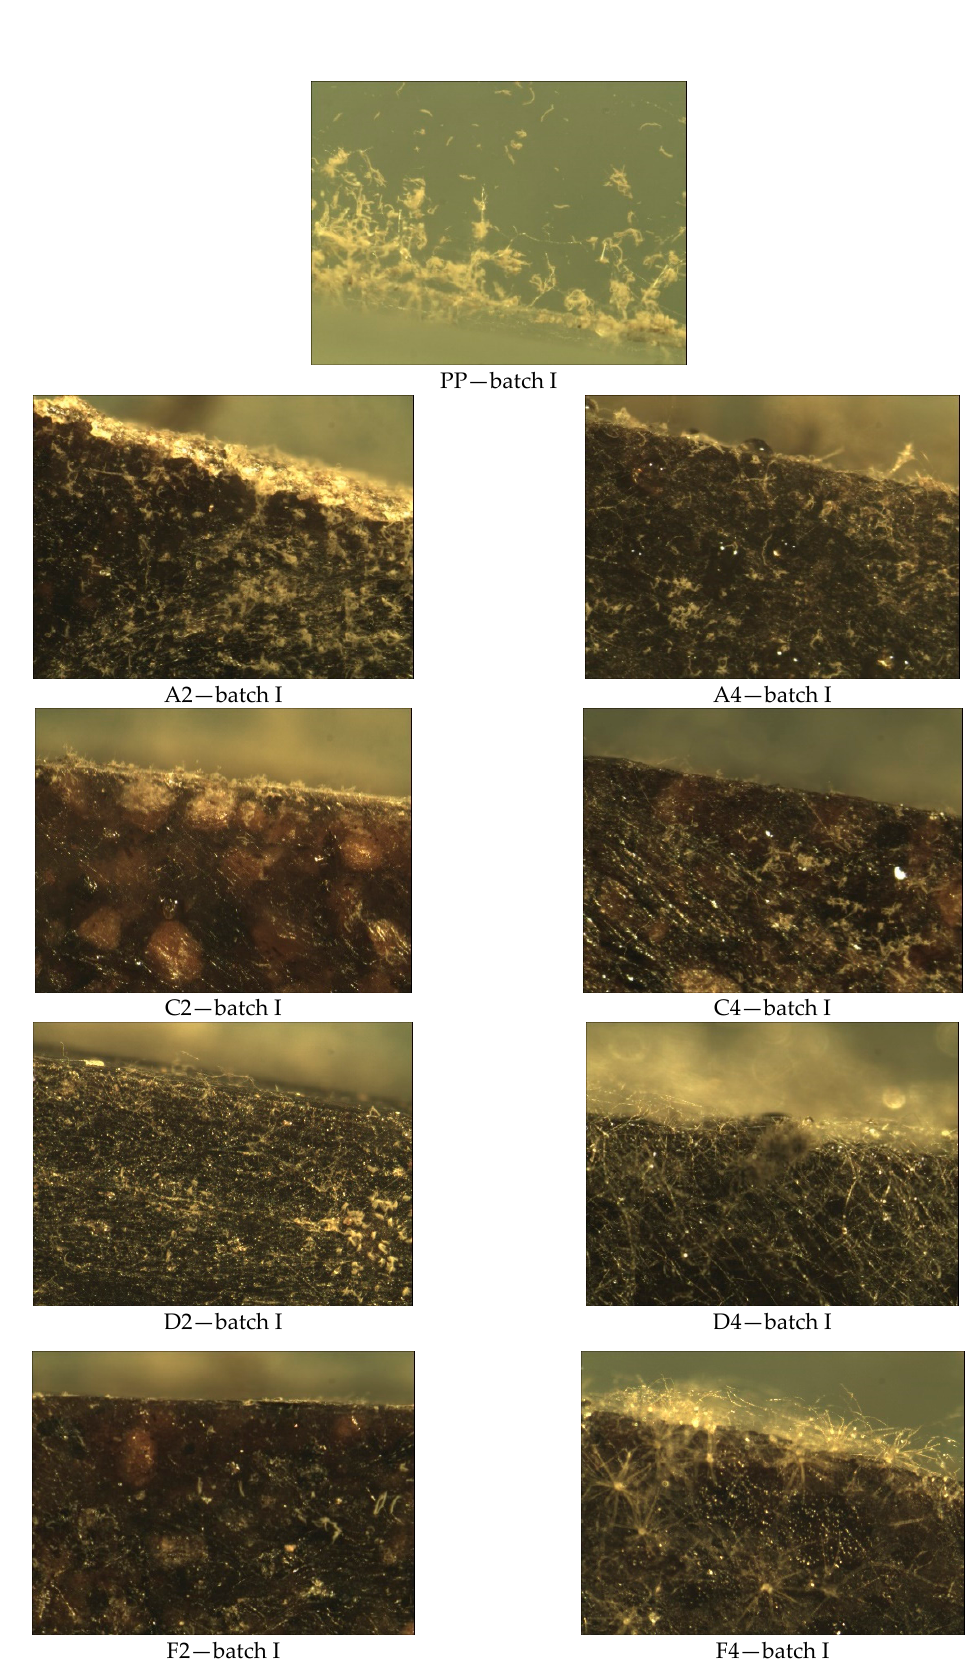
Figure 7. Methods A—results of microscopic evaluation of batch samples: I.